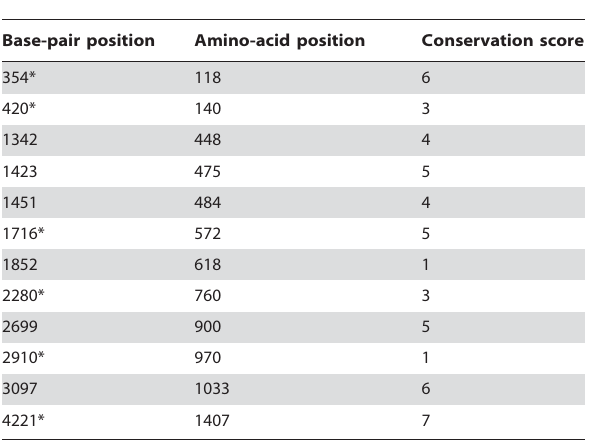
Table 2. Conservation of ADAMTS13 variants across